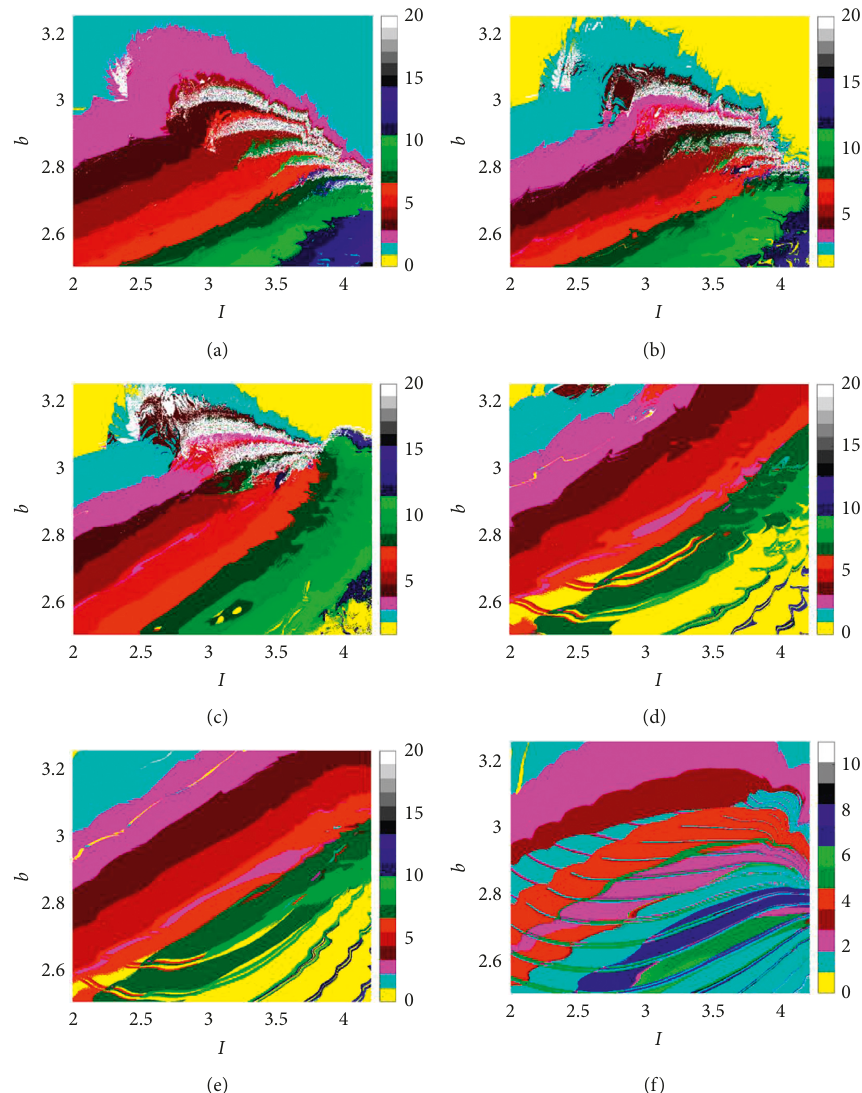
Figure 5: Two-parameter bifurcation diagrams of the coupled model with I ∈ [ 2 , 4 . 2 ] and b ∈ [ 2 . 5 , 3 . 25 ] . For (a) D � 3, τ � 0 . 01; (b) D � 5, τ � 0 . 01; (c) D � 3, τ � 0 . 05; (d) D � 5, τ � 0 . 05; (e) D � 3, τ � 0 . 1; and (f) D � 5, τ � 0 . 1. Different colors are used to draw different firing states of the membrane voltage, and corresponding numbers are marked in the color bar on the right side of the figure. The initial values are selected with (0.1, 0.01, 1.05, 0.1, 0.01,